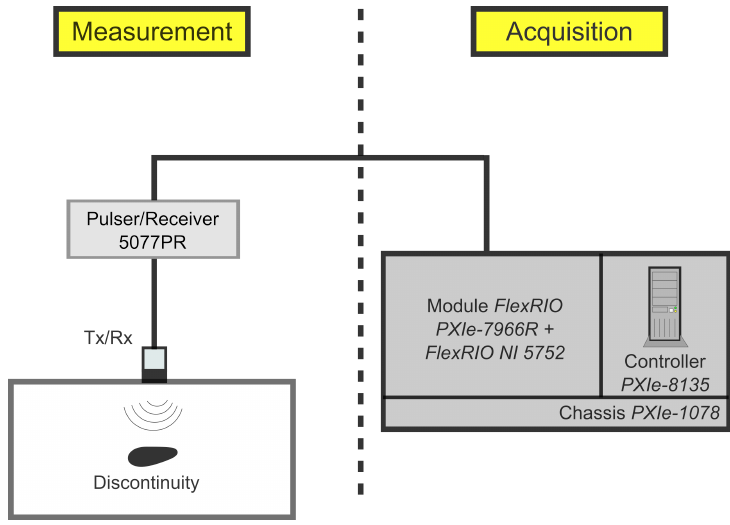
Figure 1. Block diagram of the UIS used in this work.